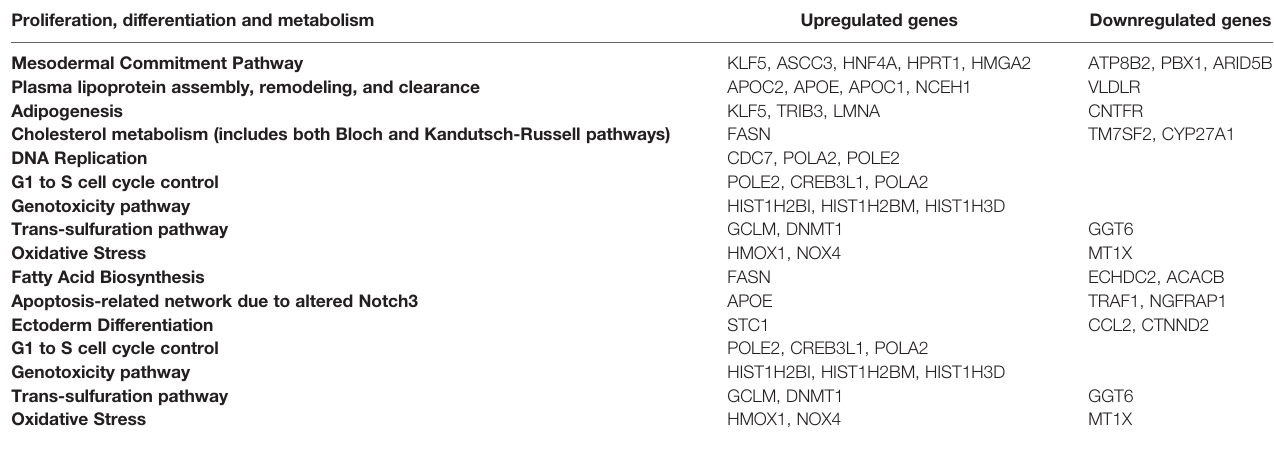
TABLE 2 | Principal pathways of Proliferation, differentiation and metabolism Cluster for the subset A. Proliferation, differentiation and